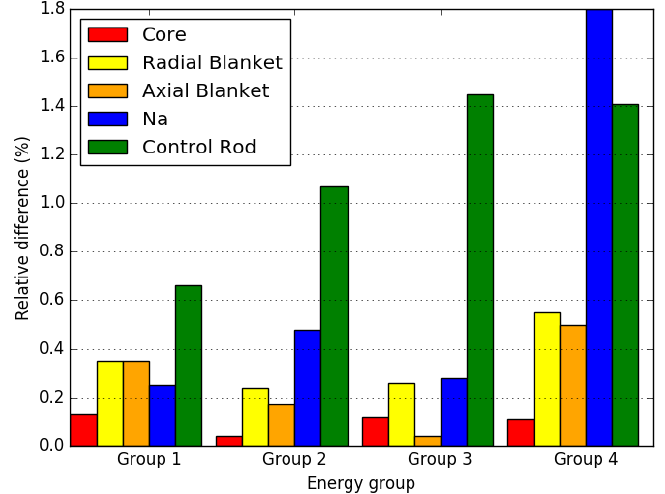
Figure 14. Comparison of region-averaged flux from reference and AZTRAN Model 2 Case 2.